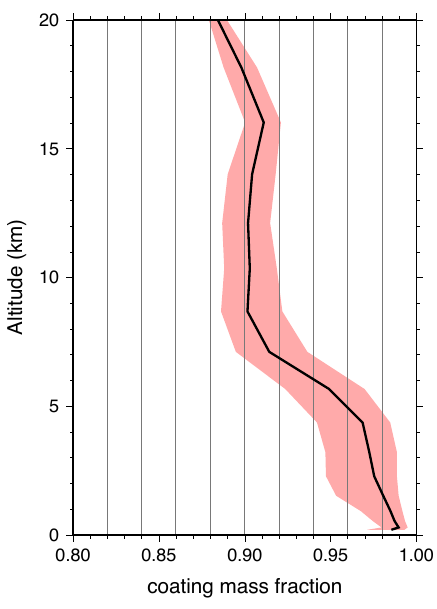
Fig. 14. Vertical profile of the mean soluble mass fraction in the internally mixed modes with BC and dust (aknmix and accmix) calculated from the reference simulation REF along the routes of flights performed by Schwarz et al. (2008). The thick solid line rep- resent the median values and the shaded areas are defined by the 25% and 75%